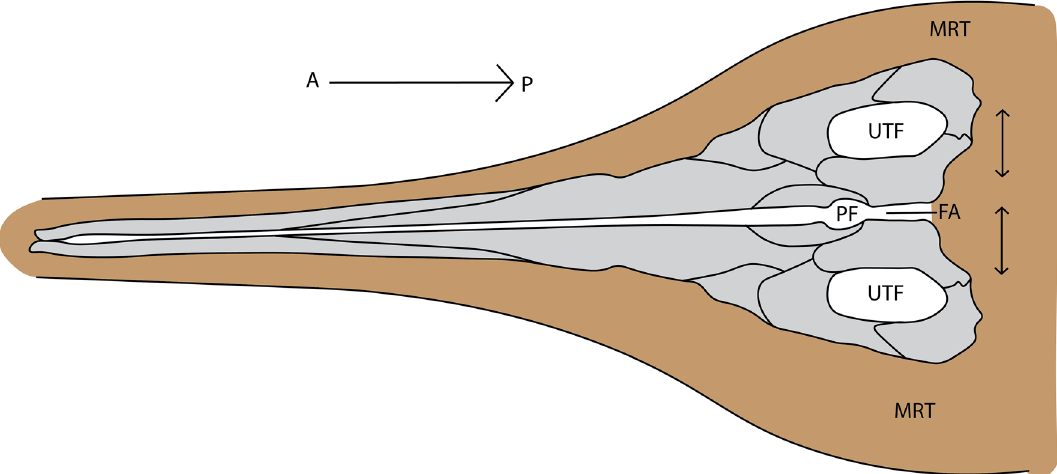
Figure 8. Schematic representation of the embryonic skull roof in the posterior reproductive tract. Embryonic skull is orientated in the most common position (tail-first birth), denoted by the arrow above the drawing (A = anterior, P = posterior). Fontanelle area is denoted in white. Arrows denote the possible movement of the two skull roof halves during birth contractions. FA fontanelle area, MRT maternal reproductive tract, PF parietal foramen, UTF upper temporal